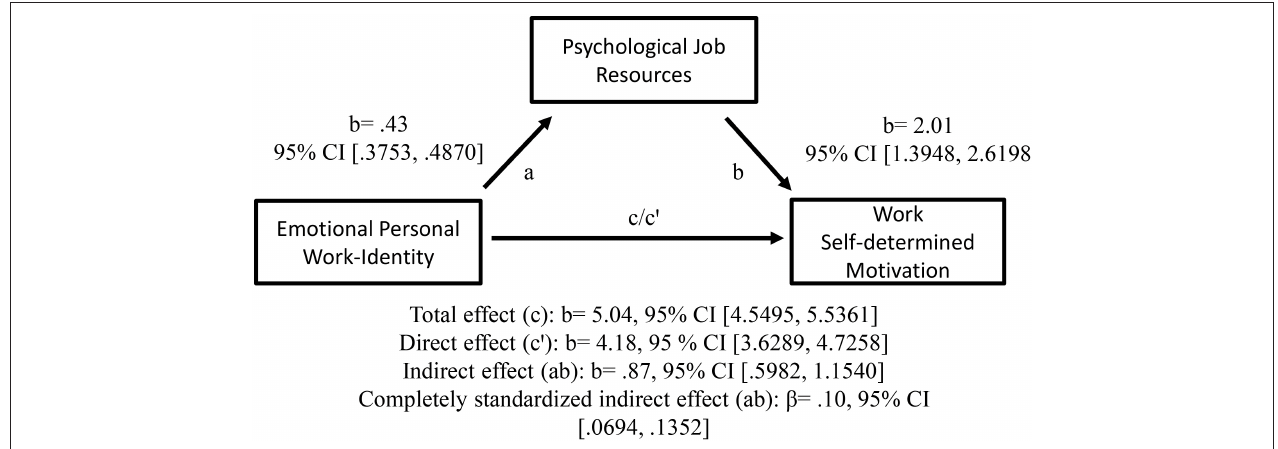
FIGURE 5 | Emotional personal work-identity as a predictor of work self-determined motivation, mediated by psychological job resources. The confidence interval (CI) for the indirect—and completely standardized indirect effect is a BC bootstrapped CI based on 5,000 samples.